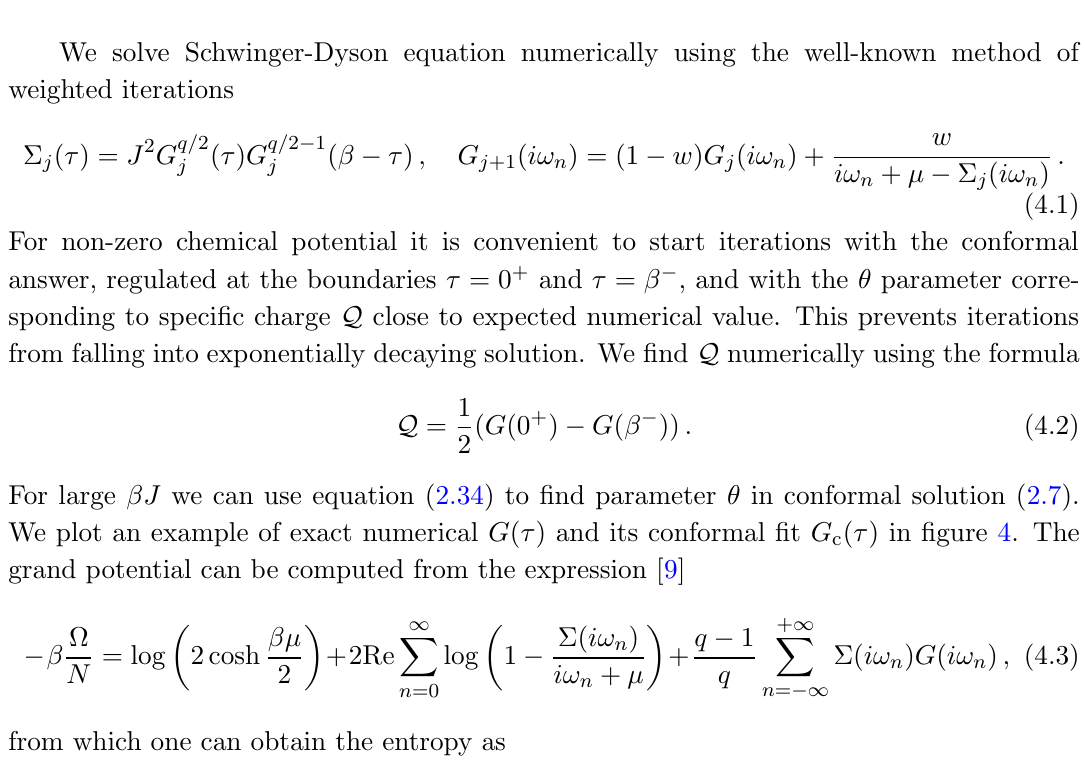
Figure 4. Plot of numerical solution for G ( (cid:28) ) at q = 4, (cid:12)J = 200 and (cid:12)(cid:22) = 20. The dashed line is conformal solution (2.7) with (cid:18) found from numerical Q using the formula